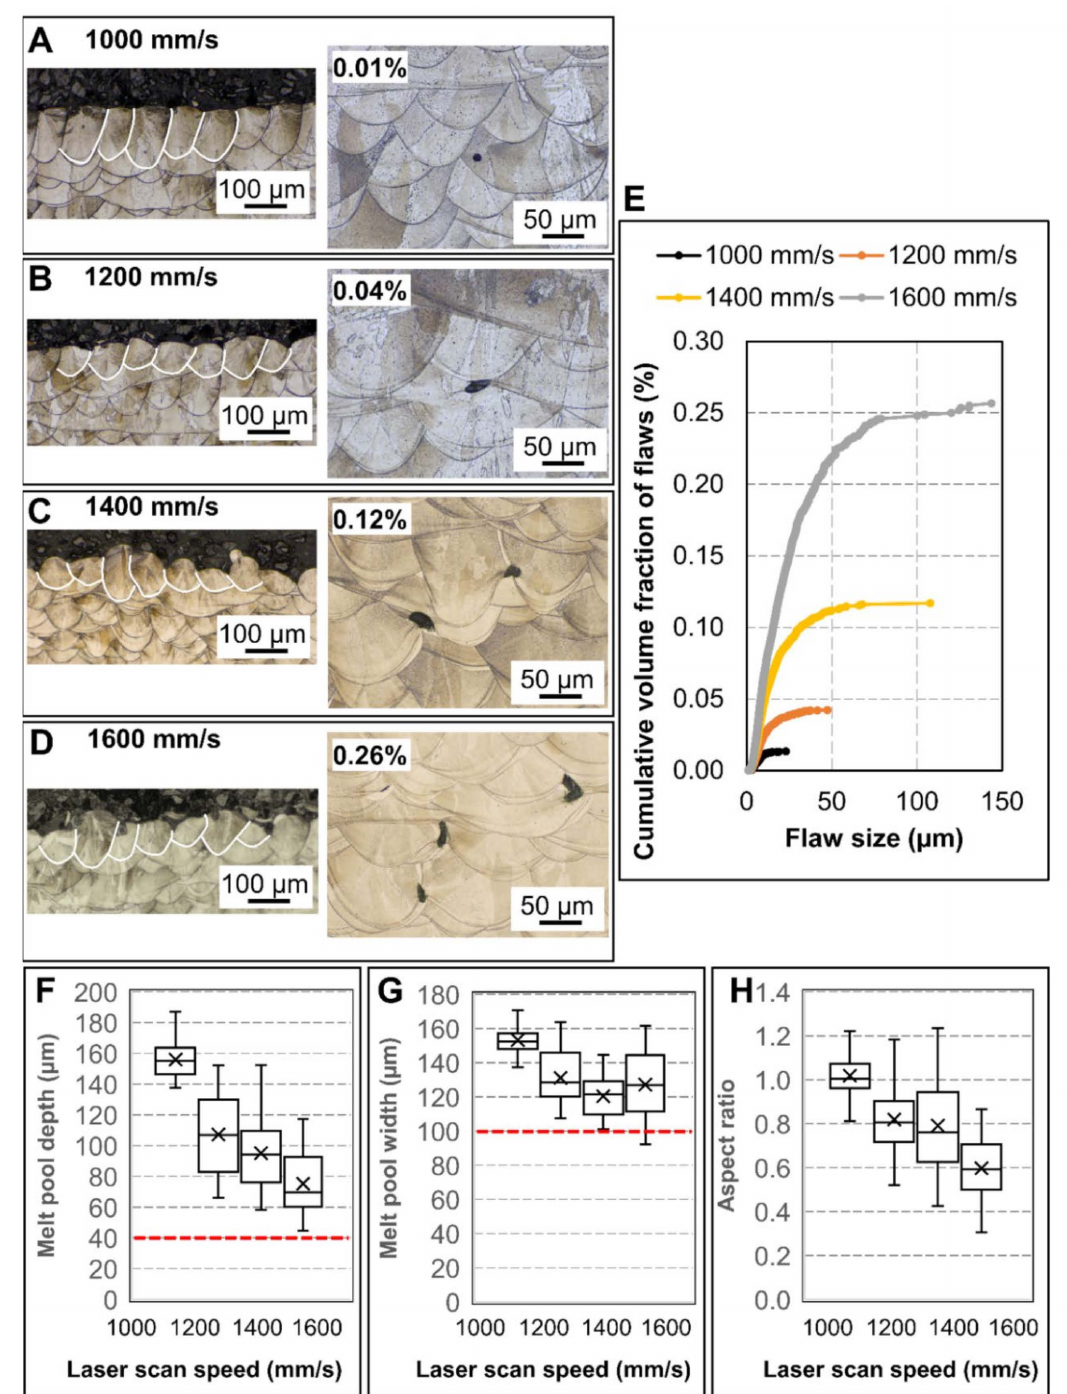
Figure 10. Influence of laser scan speed on melt pool geometries and flaw populations in the conduction regime. Microstruc- ture of specimens manufactured with a laser scan speed of: 1000 mm/s ( A ); 1200 mm/s ( B ); 1400 mm/s ( C ); 1600 mm/s ( D ); otherwise identical parameters (nominal laser power 300 W and layer thickness 40 µ m). The volume fraction of flaws is indicated. Melt pool boundaries are highlighted for easier visualization. Corresponding flaw size distributions ( E ). Influence of laser scan speed on melt pool: depths ( F ); widths ( G ); aspect ratios ( H ). The red dashed lines represent the nominal layer thickness ( F ) and hatch spacing ( G ) used in